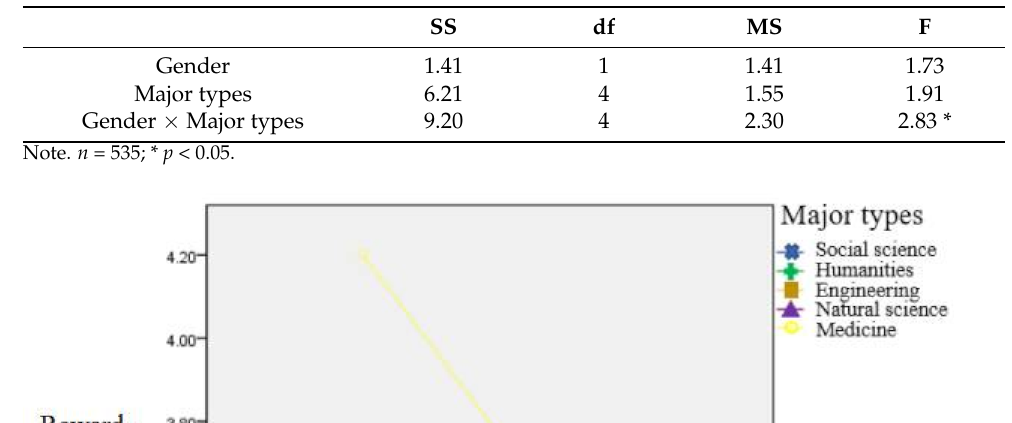
Two-way ANOVA results of reward-oriented involution in terms of gender and academic background.